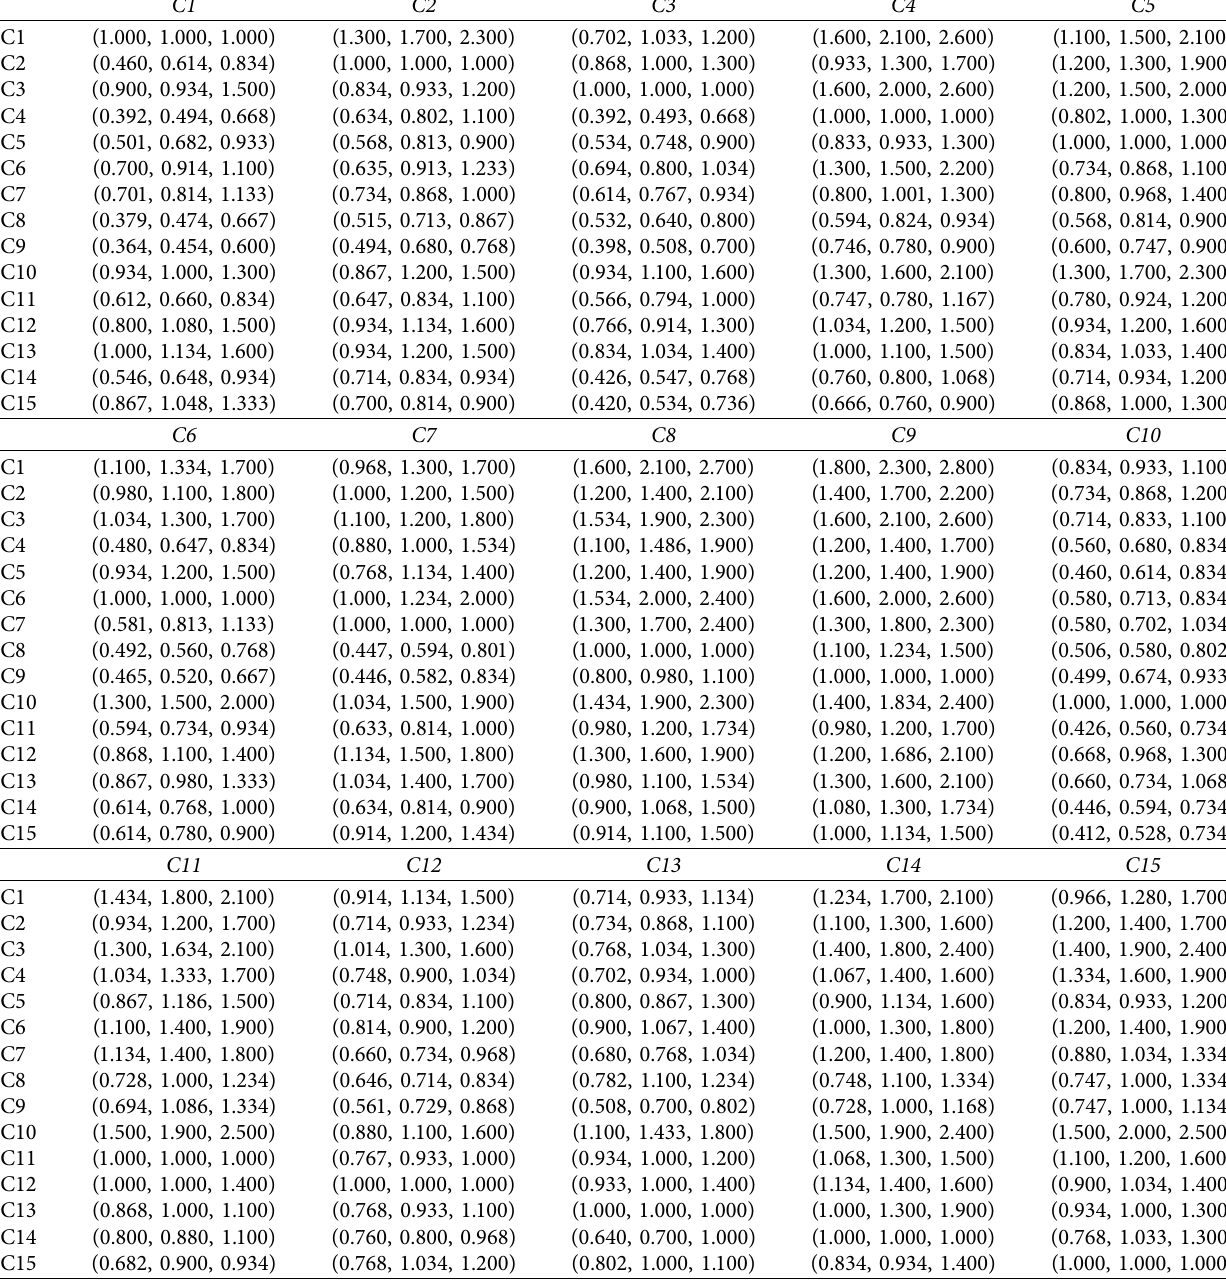
Table 5: The fuzzy evaluation matrix ( 􏽥 X ).